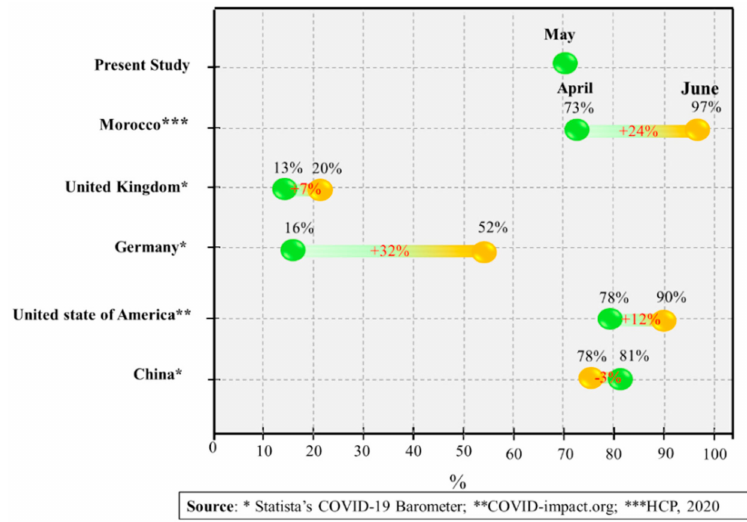
Figure 7. Masking up in a fight against COVID-19 between April and early June 2020 (results based on an online survey).